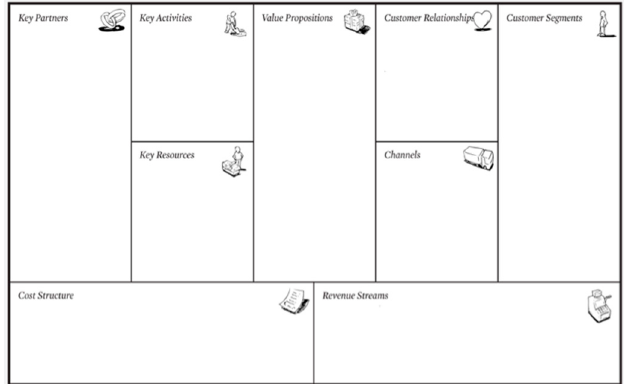
Figure 2. The Business Model Canvas (BMC). Source: [99].